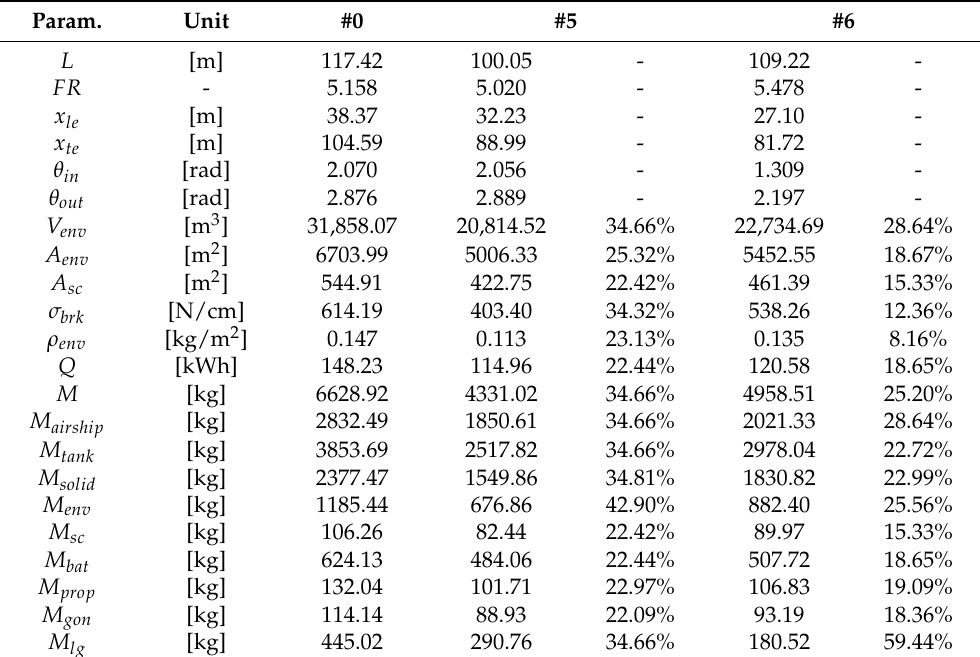
Table 14. Effect of technological advancements and design improvements on optimal design for operation at 20 km altitude above L’Aquila, Italy (Part 3). For each case, the first column gives the absolute value of the parameter, while the second column gives the percent reduction compared to the baseline #0.